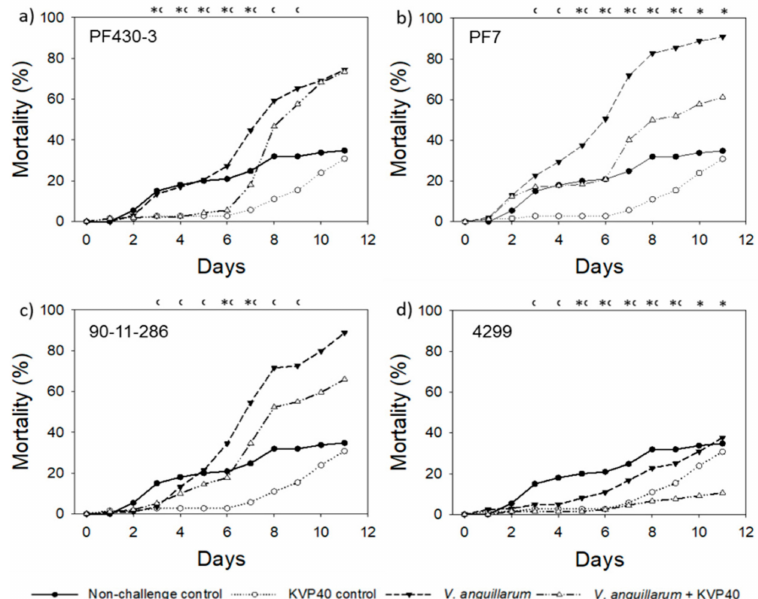
Figure 5. Cumulative percent mortality over time in cod challenge trial 2: ( a ) strain PF430-3; ( b ) strain PF7; ( c ) strain 90-11-286; ( d ) strain 4299. Significant difference in mortality between cultures “ V. anguillarum ” and “ V. anguillarum + KVP40” for individual time points is indicated by *. Significant difference in mortality between cultures “Nonchallenge control” and “KVP40 control” is indicated by c